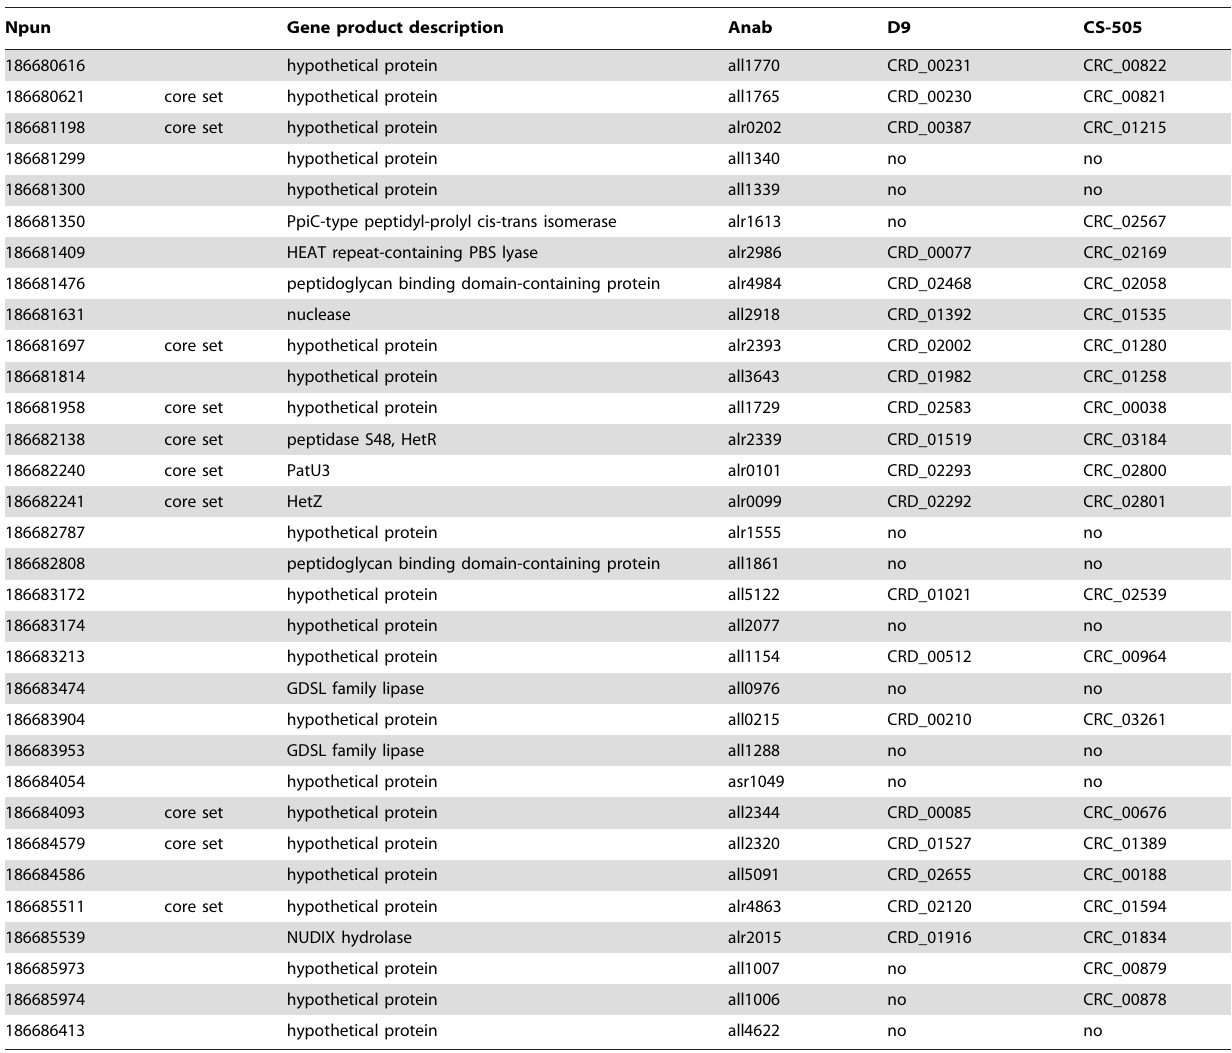
Table 4. Genes present only in filamentous